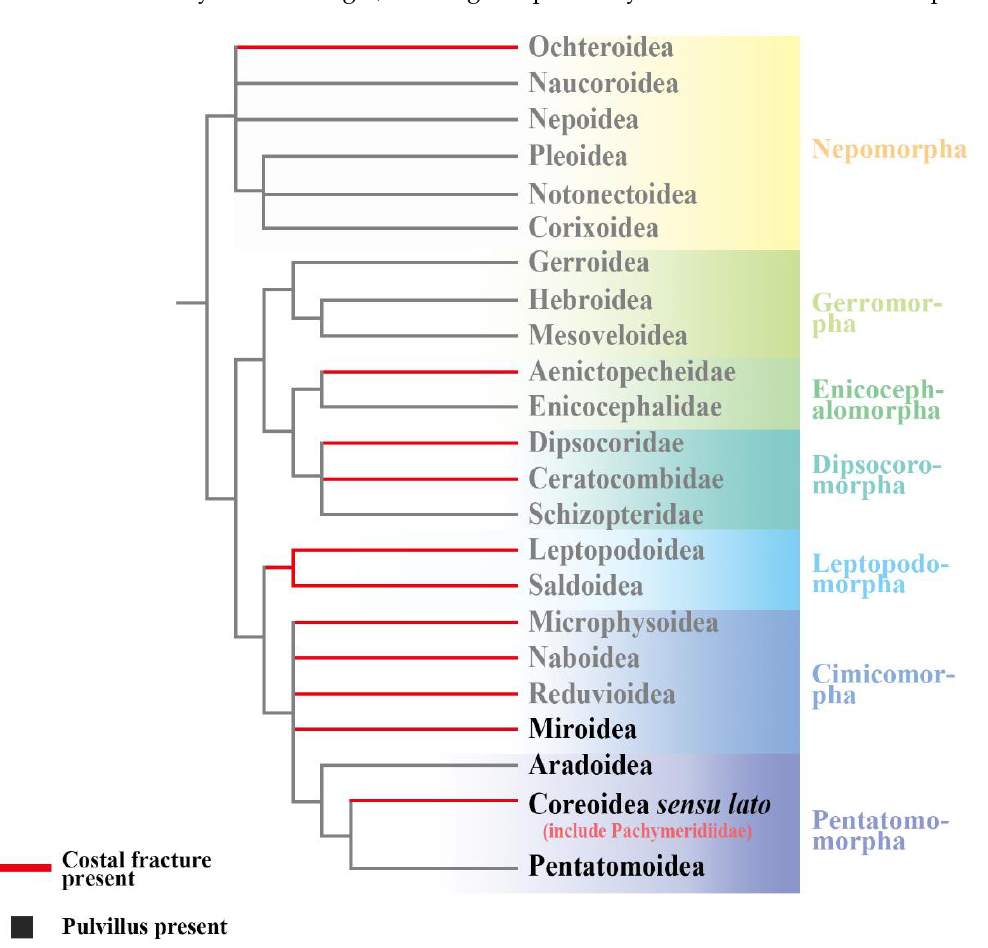
Figure 4. Phylogenetic hypothesis for Heteroptera (modified from [30]). Redline shows the costal fracture present, boldface shows the pulvillus present.